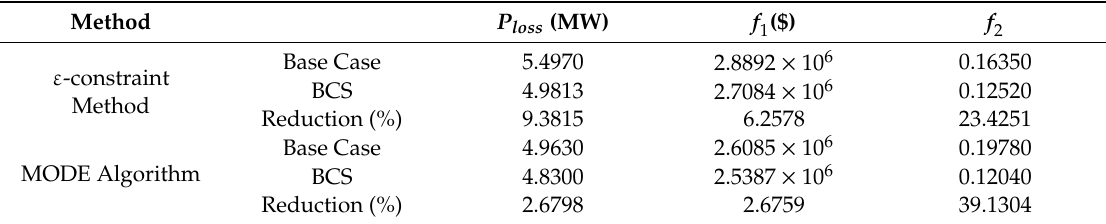
Table 5. Comparison of the obtained results between the ε -constraint method and MODE algorithm for the BCS under the same operating conditions.